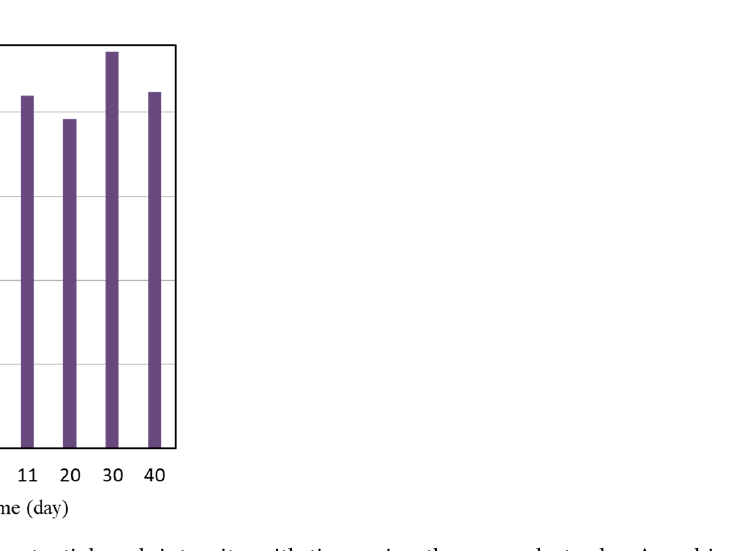
Figure 11. SIA-DEP potential peak intensity with time using the same electrode. Ascorbic acid concentration is 280.0 µM under the optimum conditions of SW polarization mode.